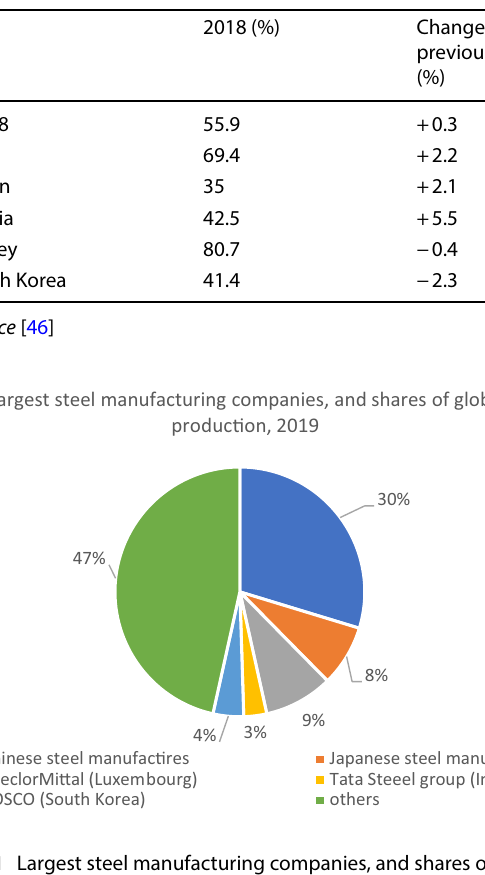
Table 9 Share of scrap (%) in crude steel production, by region, 2018